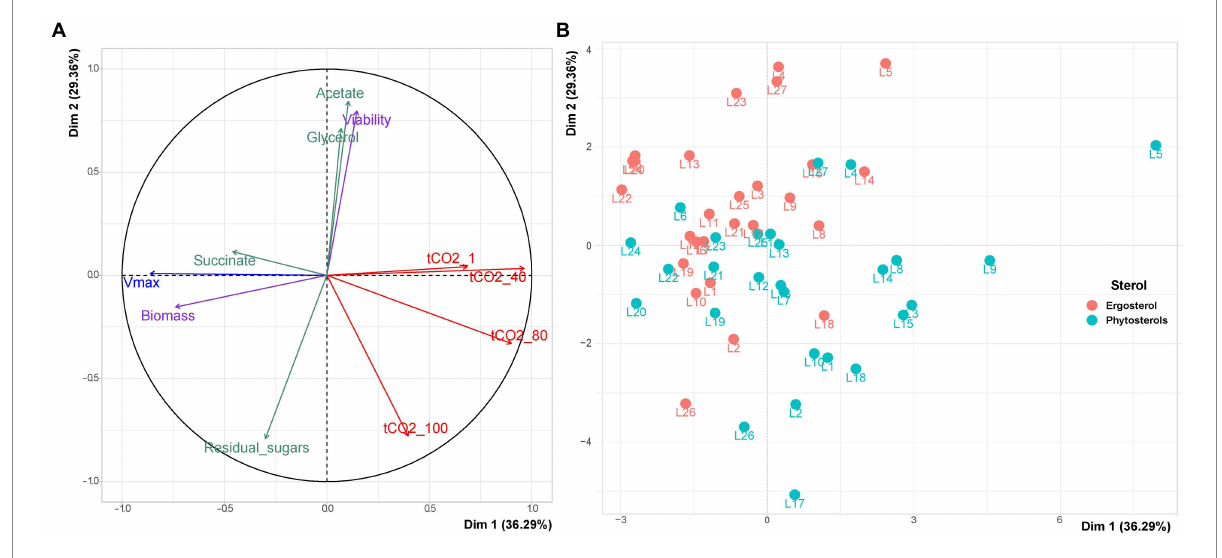
FIGURE 4 PCA for variables triplicate means of the 27 wine yeast strains under high sugars content. (A) Projection of the variables used to describe fermentation kinetics, biological variables and central carbon metabolites on the 2 main components of PCA. The PCA variables are: maximum fermentation rate (Vmax), times to achieve 1, 40, 80, and 100 g/l of released CO 2 and the end of fermentation (tCO2_1, tCO2_40, tCO2_80, tCO2_100 and tCO2_End, respectively); viability and biomass at 85% of fermentation progress (Viability and Biomass, respectively); acetate, glycerol, succinate and residual sugars at the end of fermentation. (B) Projection of the